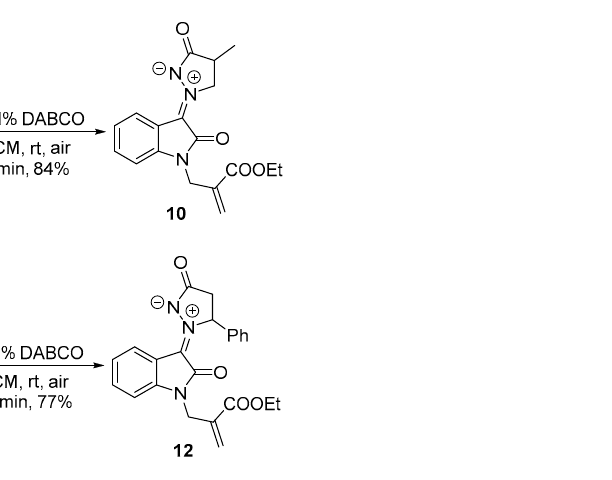
Molecules 2023 , 28 , x FOR PEER